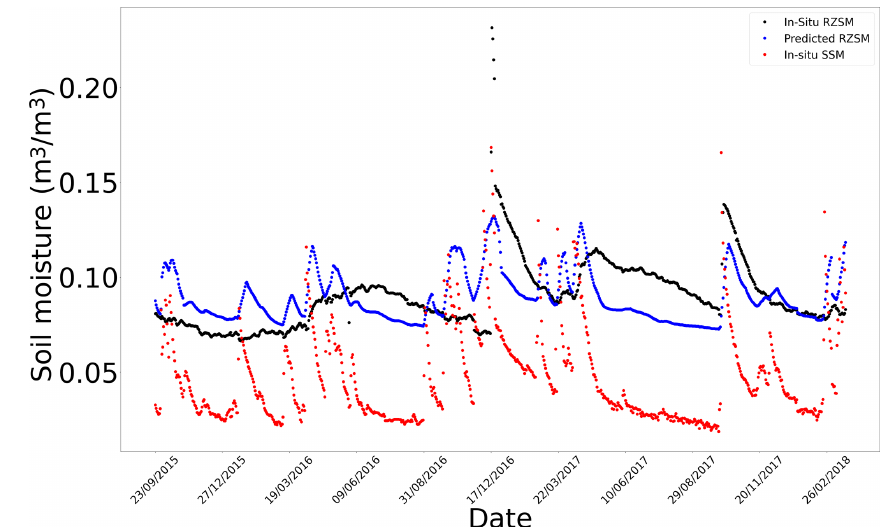
Figure G7. In situ SSM, in situ RZSM, and predicted RZSM series at station Hmidate_163 (Tunisia) with model ANN_SSM.